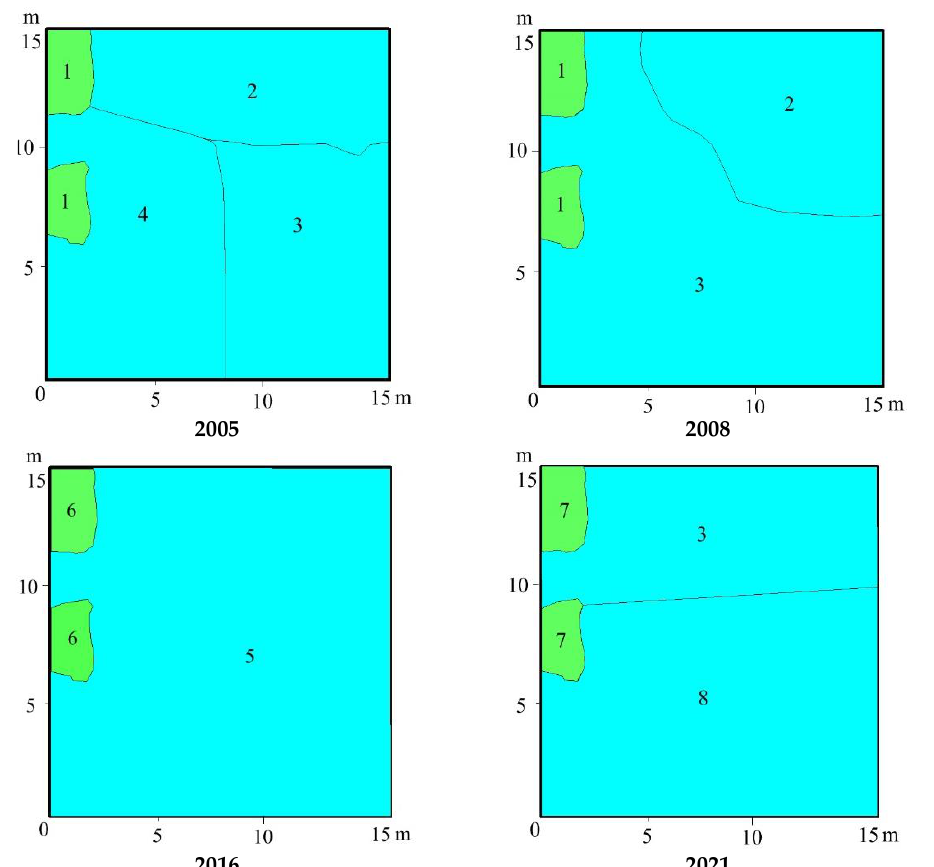
Figure 10. Changes in vegetation on permanent plot No. 6: 1 Pinus sylvestris – Vaccinium uliginosum + Chamaedaphne calyculata – Sphagnum fallax ; 2 Phragmites australis – S. fallax ; 3 C. calyculata + Oxycoccus palustris – S fallax ; 4 Carex rostrata – S. fallax ; 5 C. calyculata + P. australis – S. fallax ; 6 Calluna vulgaris + Ledum palustre + V. uliginosum – S. fallax ; 7 V. uliginosum + L. palustre – S. fallax ; 8 C. calyculata + C. rostrata – S fallax .